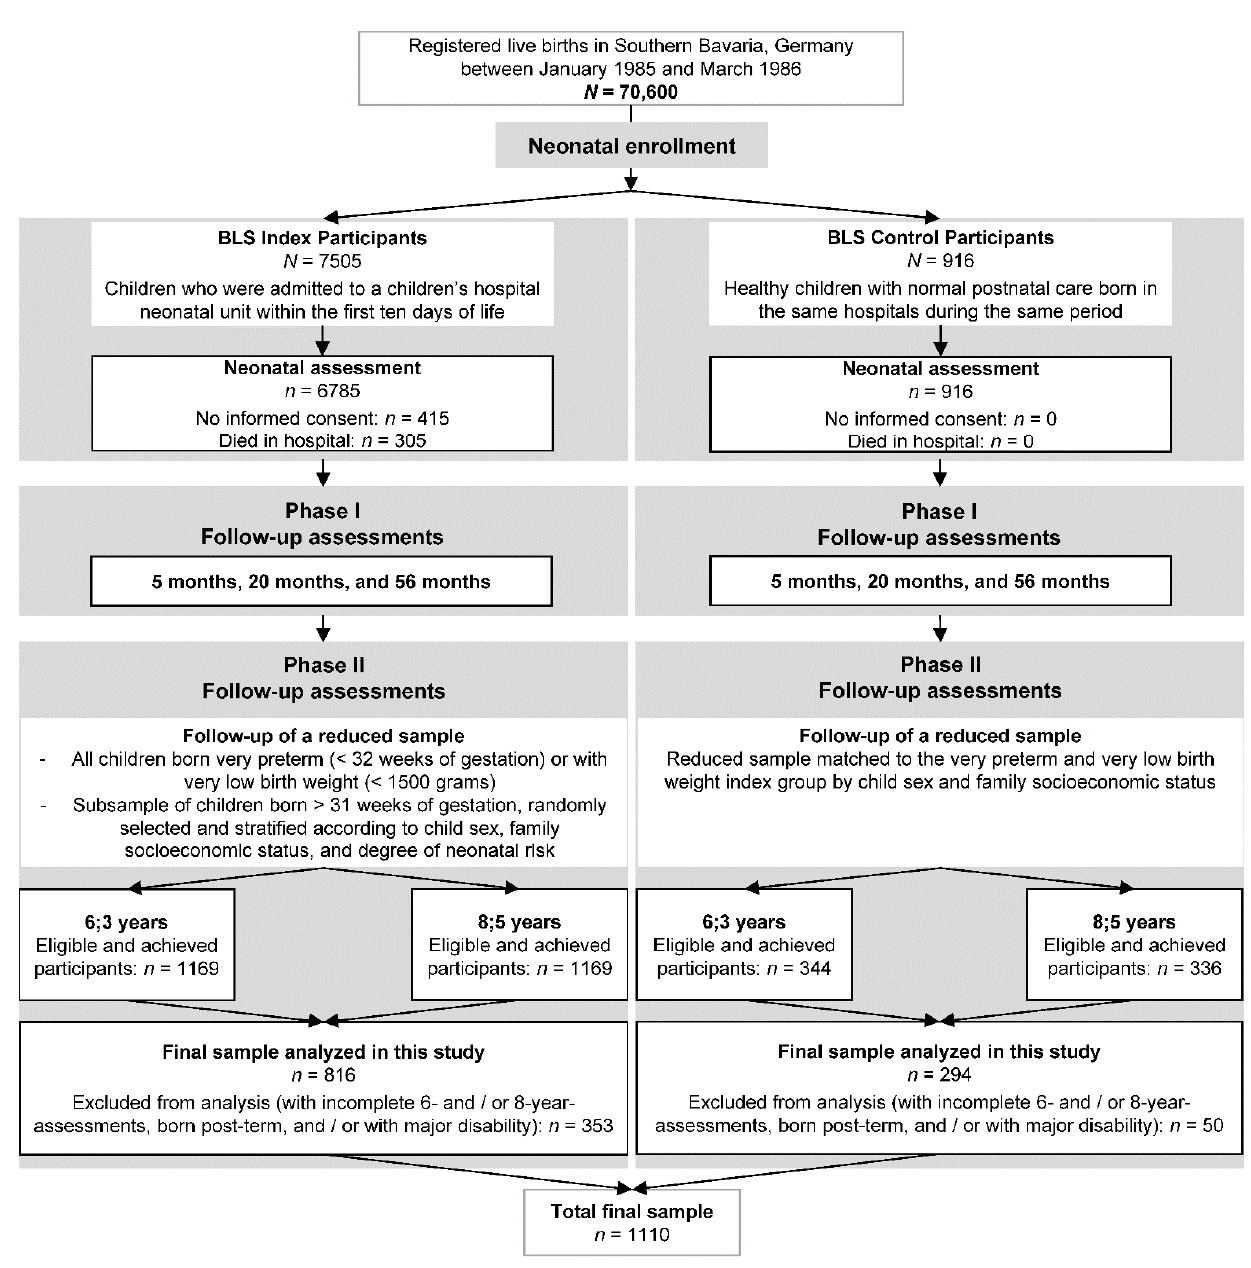
Figure 1. Flow-chart of participants. Flow of participants through the first two phases of the Bavarian Longitudinal Study until the age of 8 years (adapted from [64]). BLS, Bavarian Longitudinal